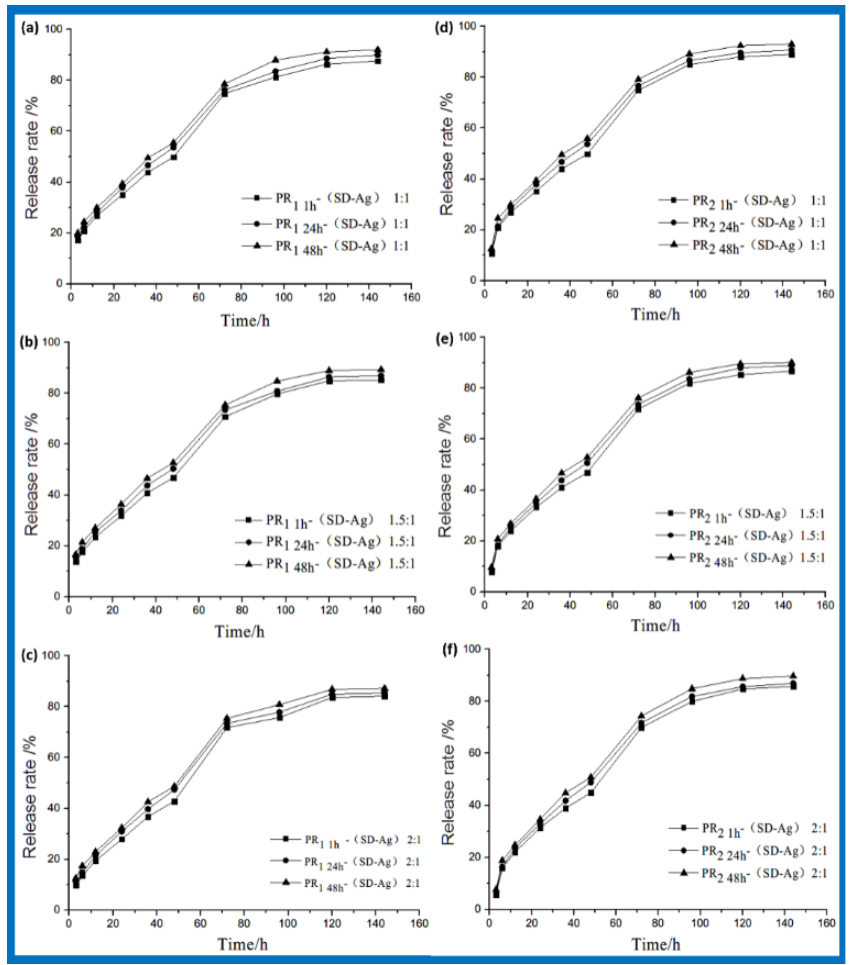
Figure 3. In vitro release profile of ( a , b , c ) PR 1 t -(SD-Ag) and ( d , e , f ) PR 2 t -(SD-Ag) with different mass ratios of polyrotaxane and silver sulfadiazine.